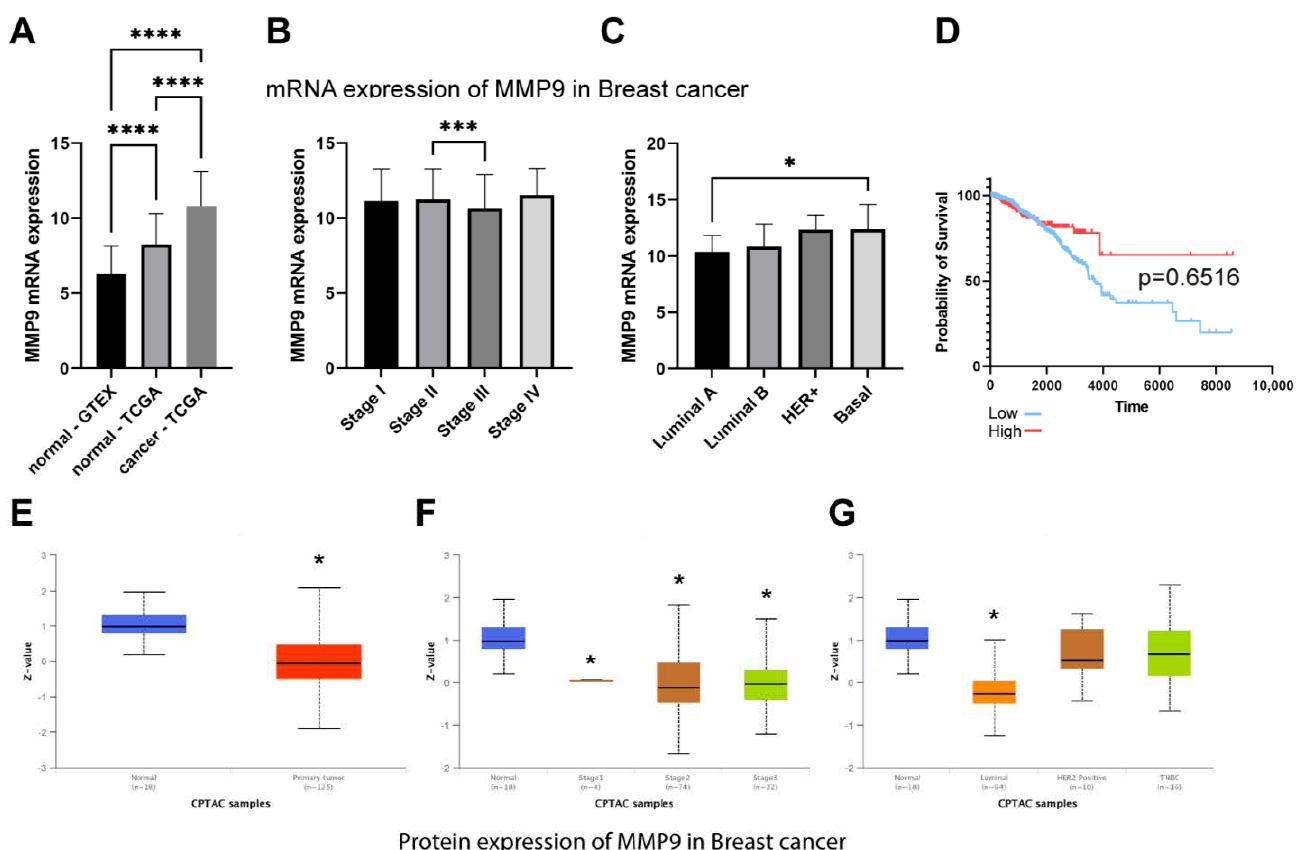
Figure 2. The expression of MMP-9 mRNA in GTEx and TCGA breast cancer cohort. ( A ) MMP-9 expression in normal and tumor tissue, ( B ) MMP-9 expression in different tumor stages, ( C ) The comparison of MMP-9 expression among PAM50 subtypes. ( D ) Overall survival of TCGA breast cancer cohort. There were no significant differences for patients with low and high MMP-9 mRNA expression. The survival curves were compared using Log-rank (Mantel-Cox) test. p < 0.05 was considered significant. The analysis of MMP-9 proteins in breast cancer patients (CPTAC cohort). ( E ) MMP-9 expression in normal and tumor tissue, ( F ) MMP-9 expression in different tumor stages, ( G ) The comparison of MMP-9 expression among PAM50 subtypes. The asterisks point to statistically significant differences (Kruskal-Wallis test with Dunn’s multiple comparison test). ‘*’ p ≤ 0.05, ‘***’ p ≤ 0.001, and ‘****’ p ≤ 0.0001